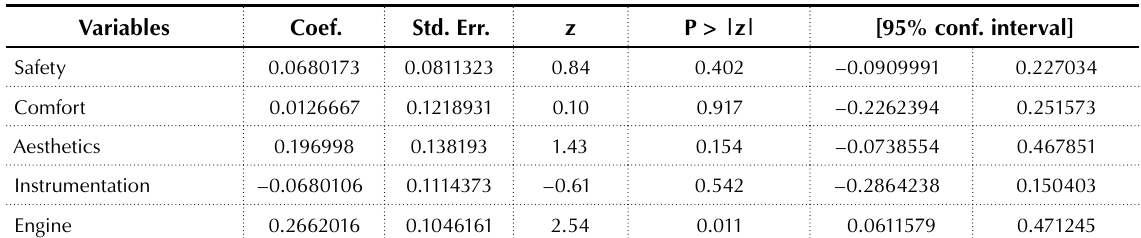
Table 4. Output sheet from Stata